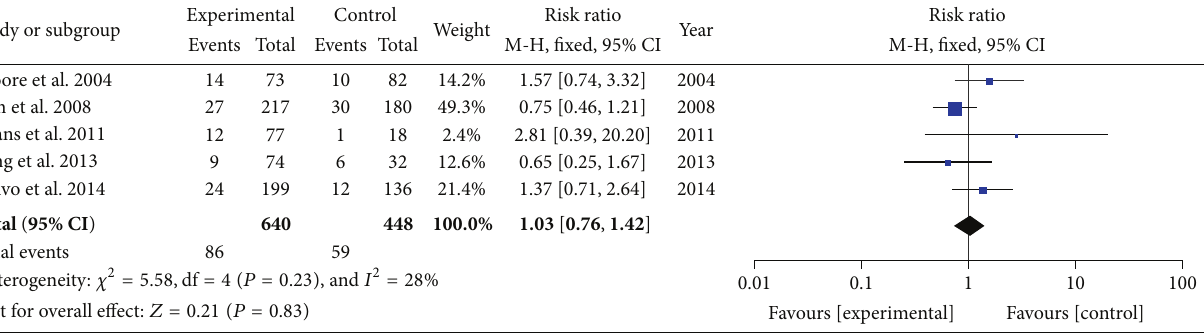
Figure 2: Standard forest plot of the RR for pCR rates comparing longer time intervals with shorter intervals at 6 weeks.